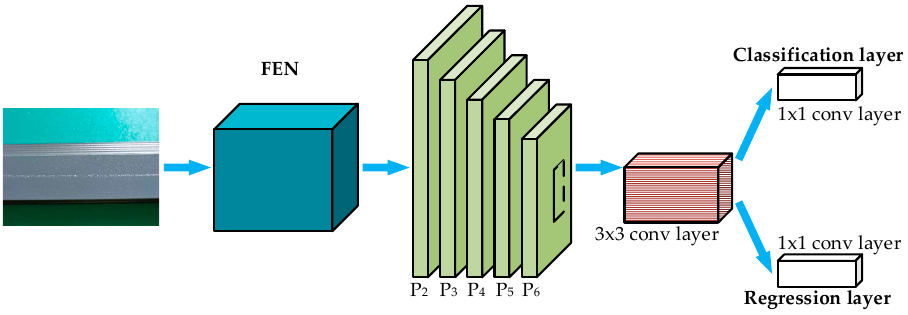
Figure 7 . Structure of the improved RPN.